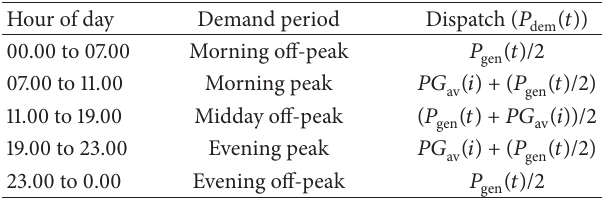
Table 1: Dispatch curve